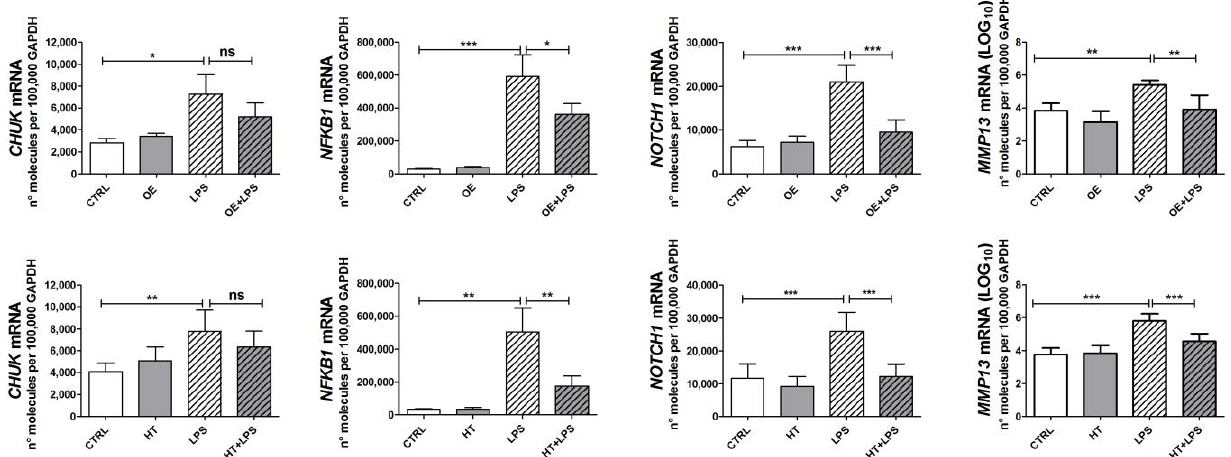
Figure 4. Effects of OE and HT on relevant intermediates of signaling pathways, and on the pivotal catabolic enzyme in OA. LPS treatment increases the expression of these genes in primary OA chondrocytes and pretreatment with either OE ( upper row ) or HT ( lower row ) efficiently inhibits this effect. Results are means ± SEM ( n = 4 to 9 different primary chondrocyte cultures), normalized using the reference housekeeping gene GAPDH according to the formula 2 − ∆ Ct and expressed as number of molecules per 100,000 GAPDH molecules. Statistical analysis was performed by ANOVA, followed by Newman–Keuls’ post hoc test, with * p < 0.05, ** p < 0.01, *** p < 0.001. ns = not significant.